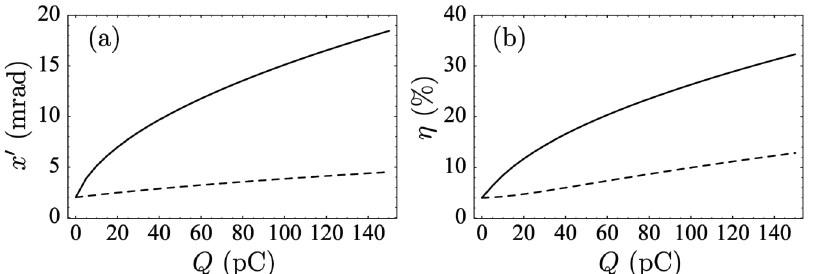
SPACE CHARGE MODELING OF DENSE ELECTRON . .